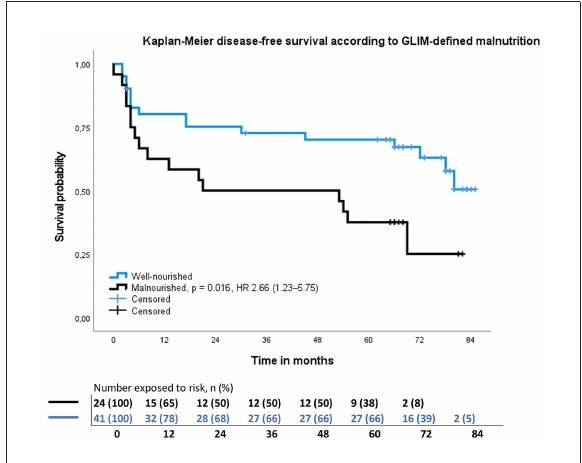
FIGURE3 Results of the Kaplan–Meier disease-free survival analysis and hazard ratio for head and neck cancer patients stratified by GLIM–defined malnutrition. Hazard ratio adjusted to age, gender, stage, and